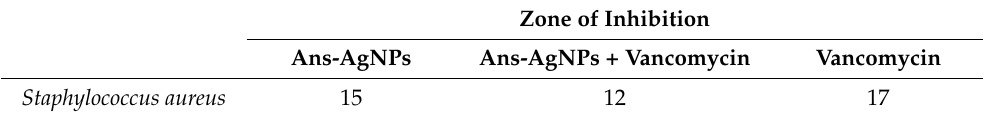
Table 3. Synergistic activity of Ans-AgNPs (4D/FM) and vancomycin against S. aureus